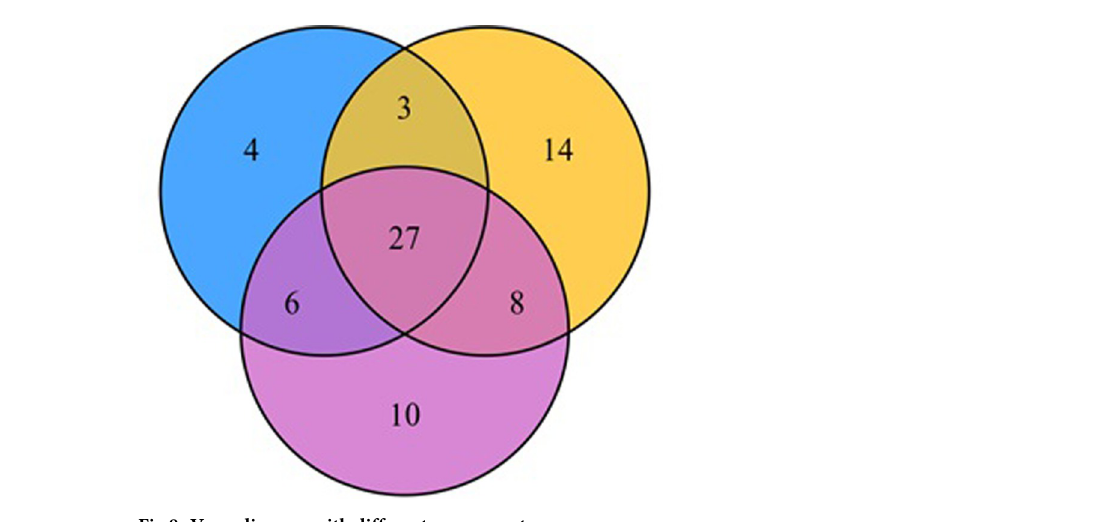
Fig 8. Venn diagram with different